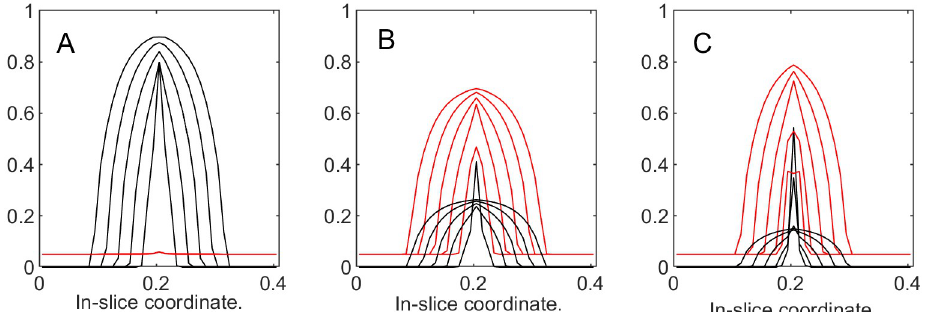
Fig 19. Tumor and ECM dynamics for various ECM active response coefficients. “Slices” at times 100, 200, ... , 500. A: α = 0. B: α = 50. C: α = 100. Note that even without “passive” response, increasing u opt